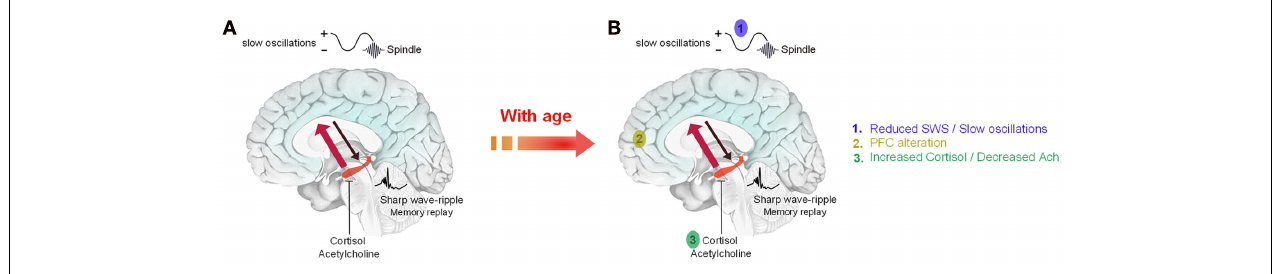
stimulate the transfer of memory traces toward neocortical sites for long term storage (red arrow).This transfer is allowed by low levels of acetylcholine and cortisol during early sleep. (B) With age, the decrease in SWS and slow oscillations combined with anatomical and functional changes in memory-related brain areas and neurochemical changes (acetylcholine, cortisol) are likely to explain that sleep-dependent memory consolidation is impaired in older adults. Adapted from Born et al.